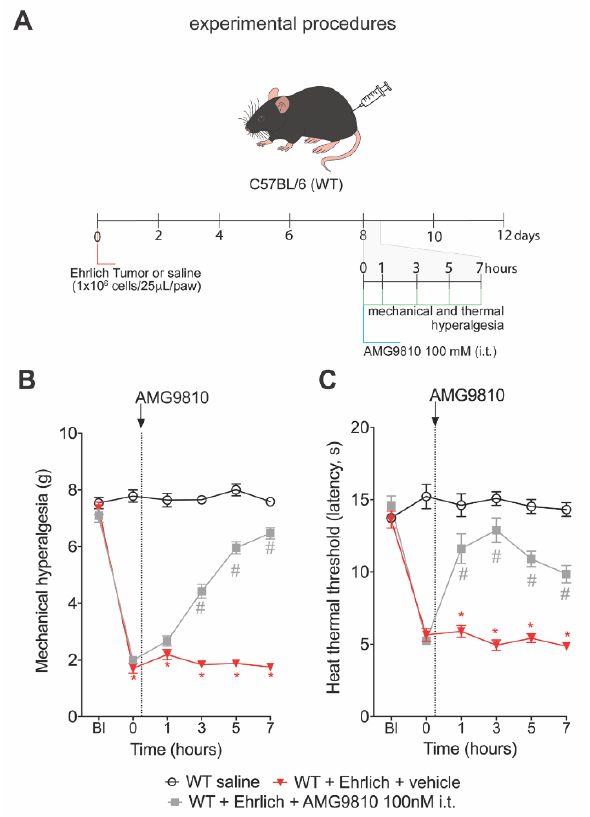
Figure 3. TRPV1 pharmacological blocking reduces Ehrlich tumor cells pain-like behavior. ( A ) Experimental design. Male WT (Wild type) C57BL/6 mice were stimulated with intraplantar Ehrlich tumor cells (10 6 cells, 25 µ L paw). Furthermore, on the 8th day, when peak pain-like behavior was achieved, AMG9810 (100 nM, 10 µ L intrathecal, competitive antagonist of TRPV1) was administered, and animals were evaluated 1 h, 3 h, 5 h, and 7 h after intrathecal treatment. ( B ) Ehrlich tumors triggered ongoing mechanical hyperalgesia and ( C ) thermal hyperalgesia and were reduced by treatment with AMG9810 compared to the vehicle (2% dimethyl sulfoxide in saline)-treated group. Results are presented as the mean ± SEM of mechanical threshold in grams (von Frey) or heat thermal threshold latency in seconds (hot plate). n = 8 mice per group (* p < 0.05 vs. saline group; # p < 0.05 vs. Ehrlich tumor cells group. Statistical information can be found at Table